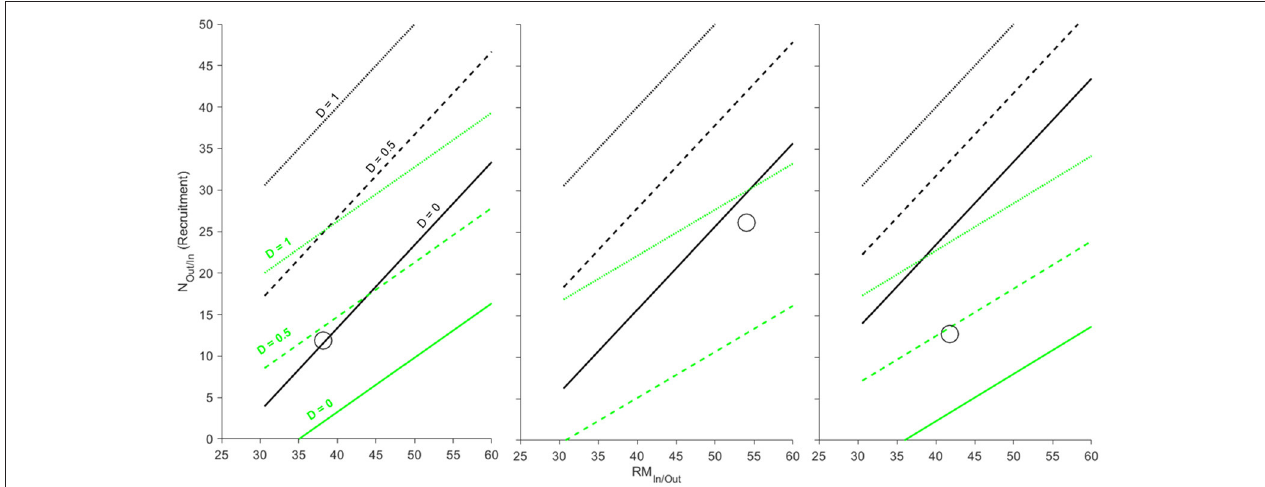
FIGURE 5 | Zero net transfer isoclines for biomass (black) and P (green) for three populations of Atlantic salmon (from left to right: Cambellton, Conne, and Western Arm; data from Ebel et al., 2015). ZNTI’s are shown for varying levels of breeding mortality ( D = 0, 0.5, 1) and are derived for population-specific differences in stage-specific size, %P, spawning run size ( N In ) and smolt production ( N Out ). Only when 100% of adults survive and become outmigrating kelts in Cambellton ( D = 0) would a net biomass export into the marine environment occur (above black line). All populations show potential for P import or export based on varying levels of breeding mortality (between green lines for D = 0 and D =